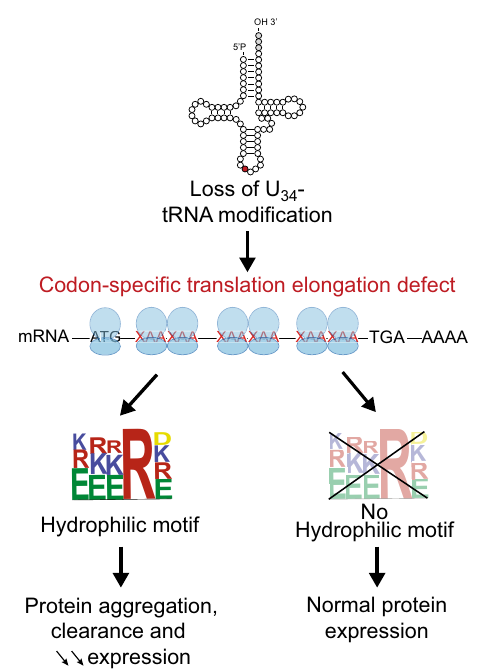
Fig. 8 Proposed model. Loss of U 34 -enzymes invariably determines pausing and accumulation of ribosomes on transcripts rich in XAA codons. The result of this pausing on protein expression is determined by the presence of hydrophilic motifs that mediate protein aggregation and subsequent clearance. See text for